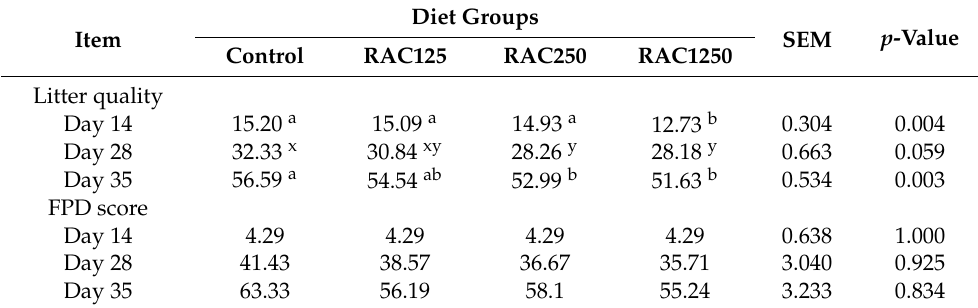
Table 5. Litter quality and footpad dermatitis (FPD) score results of trial